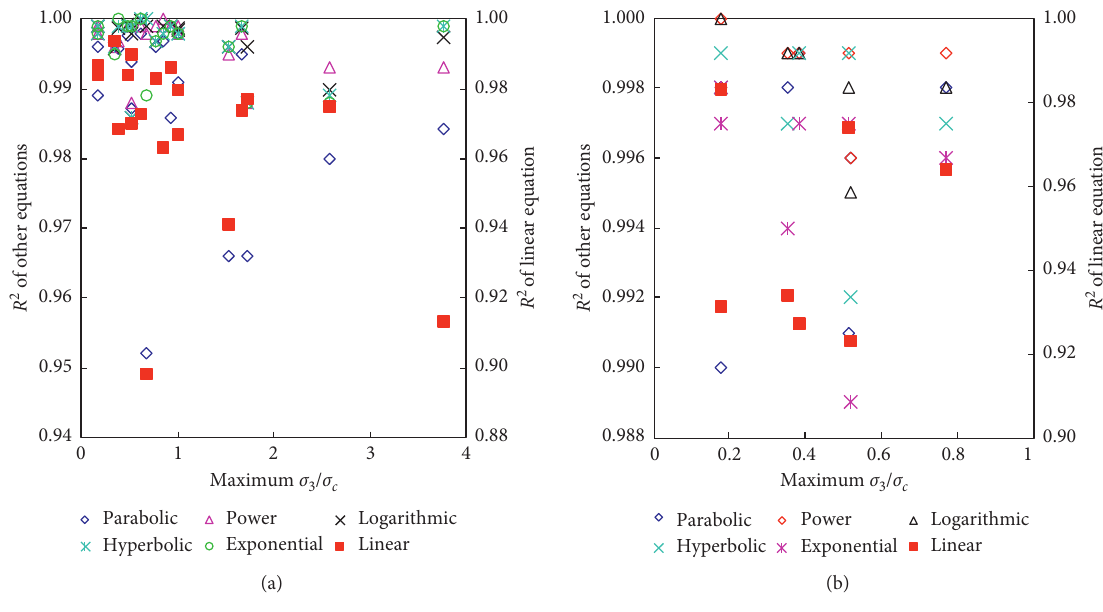
Figure 6: Regression R 2 in the Mohr stress space. (a) ( σ